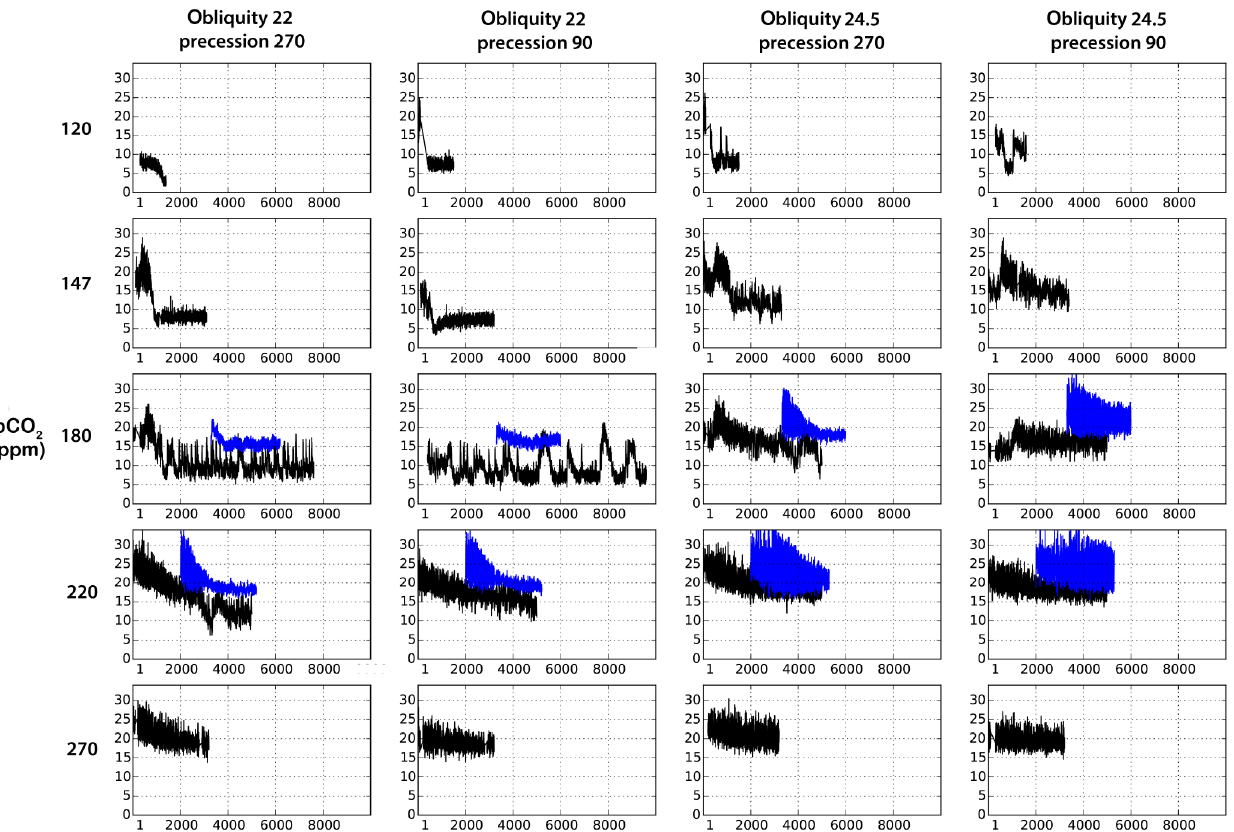
Figure 1. Time series of AMOC for the matrix of simulations with prescribed atmospheric p CO 2 (rows) and orbital configurations (columns). Black lines have preindustrial ice sheets and blue lines, when applicable, have full LGM ice sheets. The AMOC, shown on the vertical axes in sverdrups, is defined as maximum of Atlantic meridional stream function between 30 and 50 ◦ N and water depths of 500 and 5000m. Precessional phases of 270 and 90 ◦ are equivalent to strong and weak boreal seasonalities,